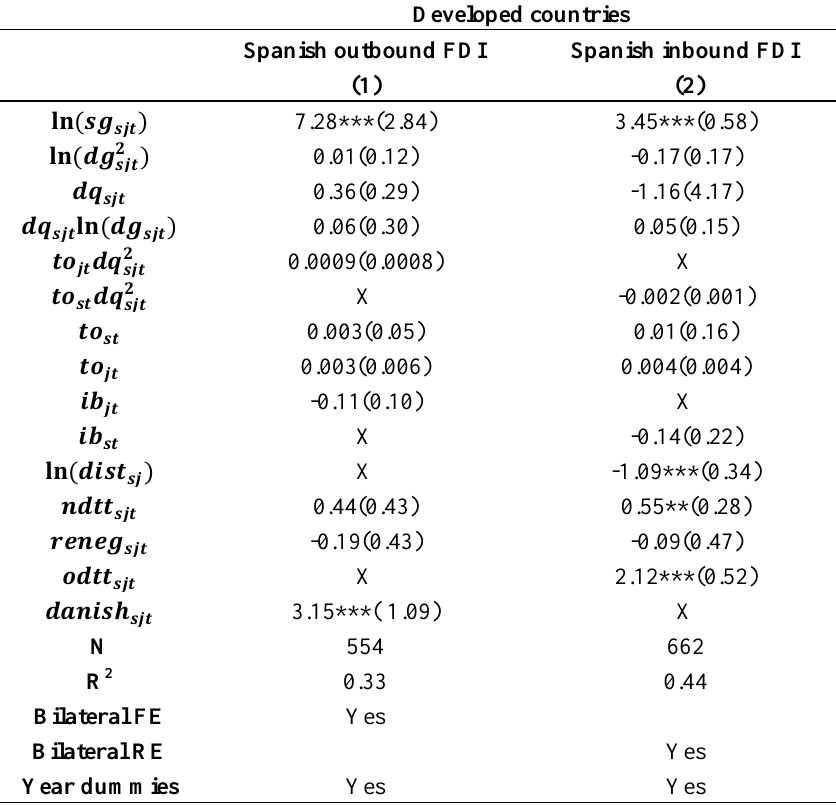
Table 4 : Effect of DTTs on Spanish inbound and outbound FDI: Types of DTTs. Developed countries Developed